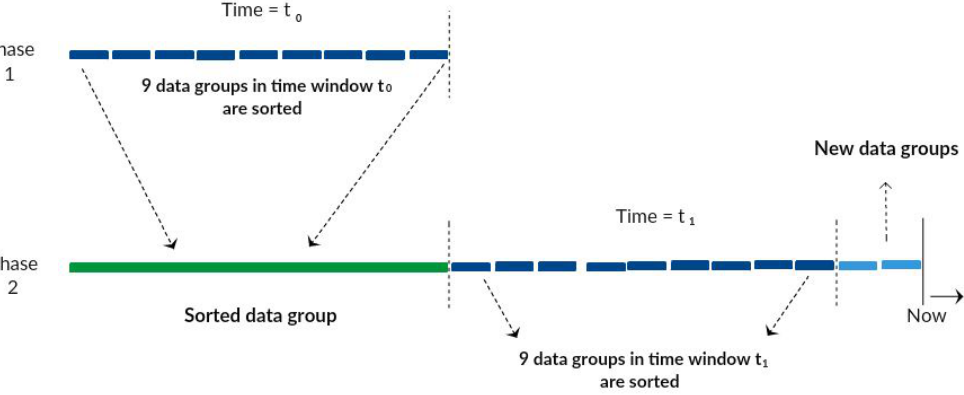
Figure 5. Example of time series organization.